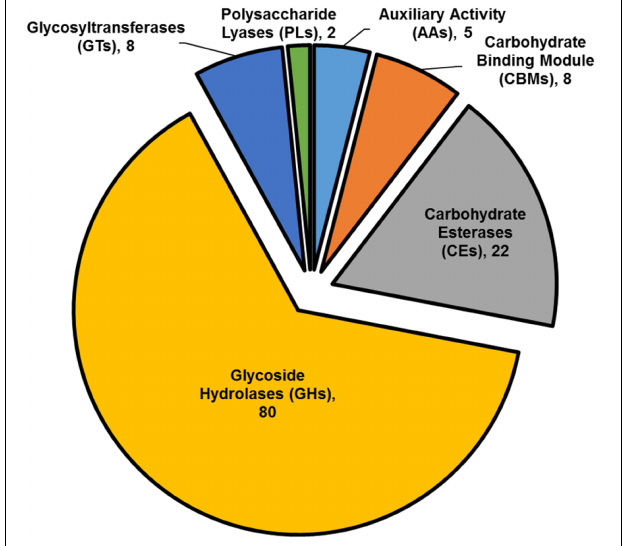
FIGURE 8 | Classification of CAZymes encoded by up-regulated DEGs. The contribution of each CAZymes family is shown. Numbers in brackets denote the number of DEGs for each